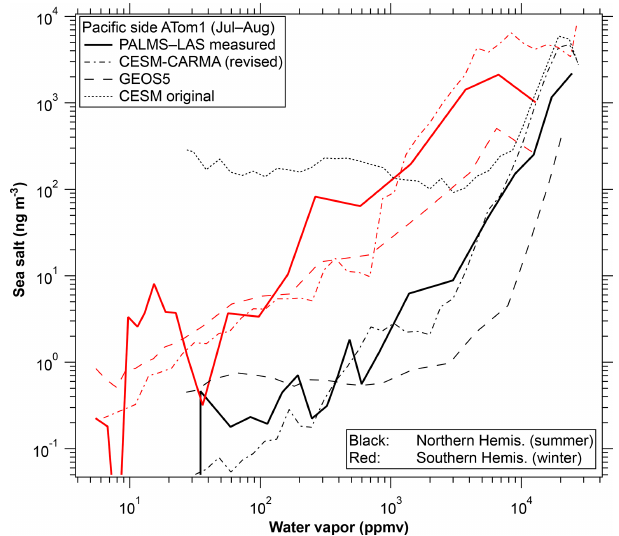
Figure 7. Model correlations for the CESM-CARMA and GEOS- 5 models. ATom2 and tropical curves are omitted for simplicity. GEOS-5 model output was sampled along the flight tracks and CESM-CARMA at all altitudes in a curtain along the flight tracks. Also shown is one curve from the CESM-CARMA model before a revised convective aerosol removal scheme was implemented (Yu et al.,